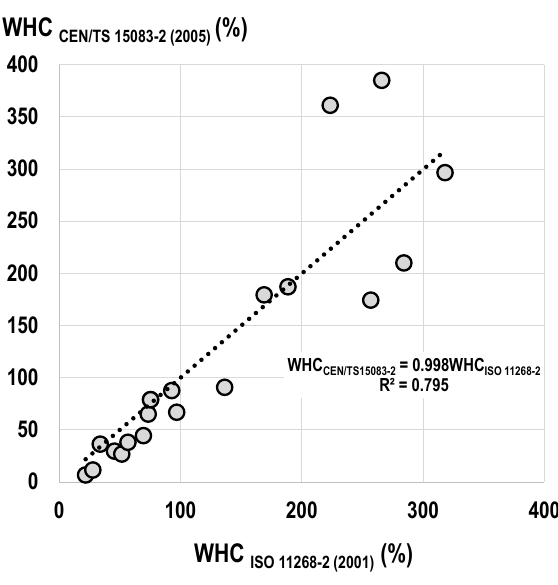
Figure 3. Interrelationship between the WHC of different substrate mixtures according to the “ droplet counting method ” [10] and the “ cylinder sand bath method ” [19].